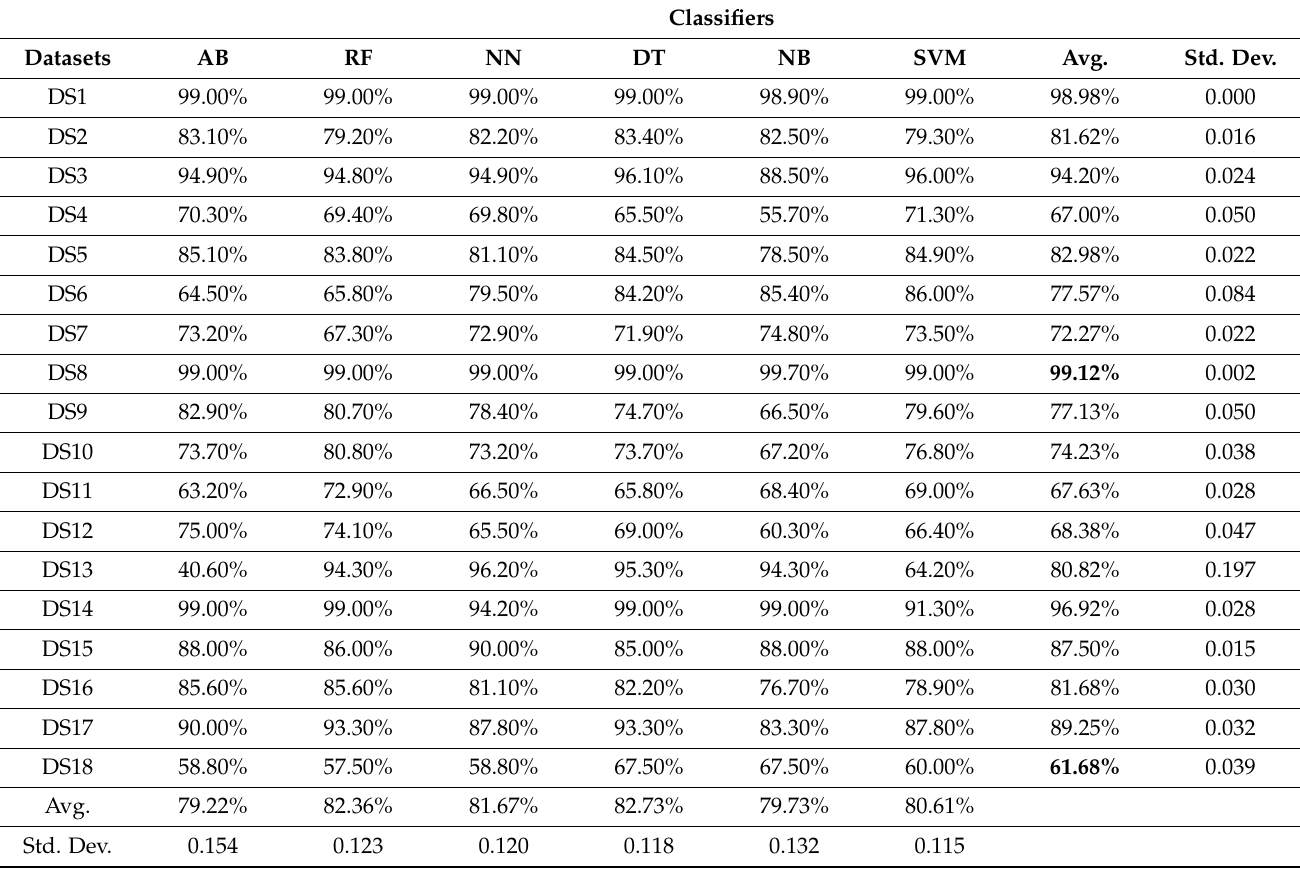
Table A2. Recall of classifiers trained on small datasets.